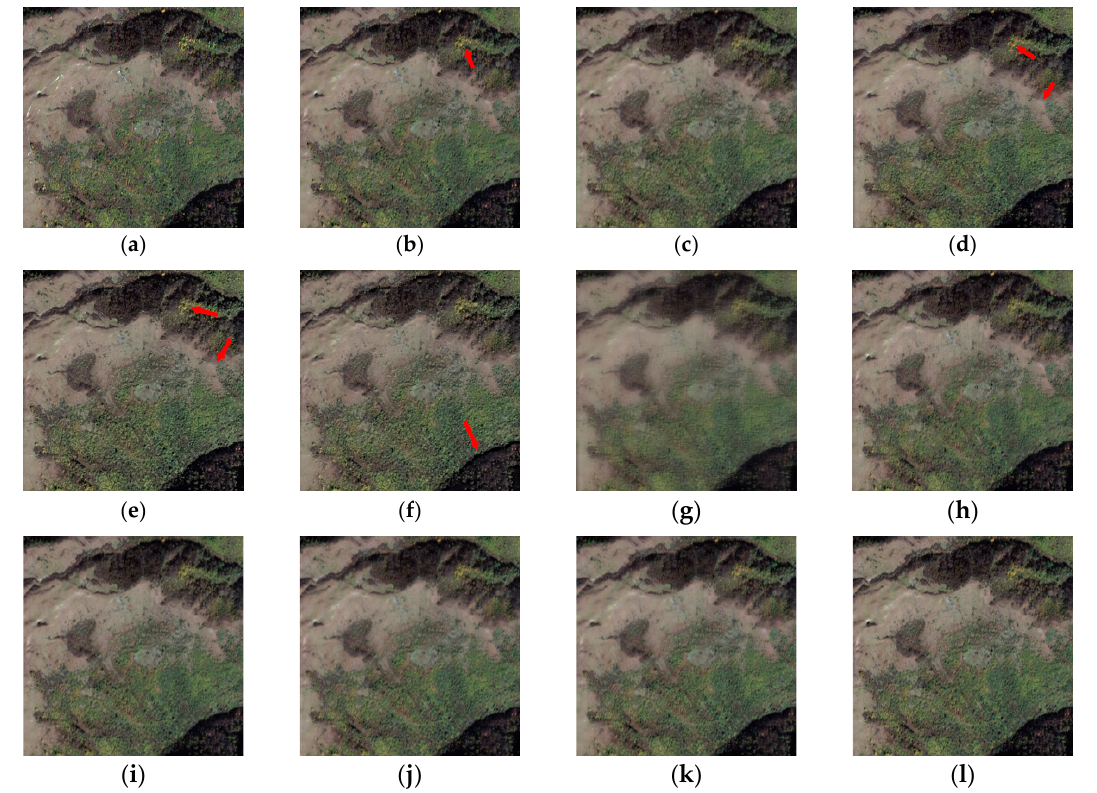
Figure 4. Fused images of different methods on IKONOS dataset. ( a ) ground truth; ( b ) our model; ( c ) PNN; ( d ) BDSD; ( e ) GSA; ( f ) Indusion; ( g ) ATWT-M3; ( h ) TFNet; ( i ) PNN+; ( j ) DRPNN; ( k ) PanNet; and ( l ) MSDCNN.